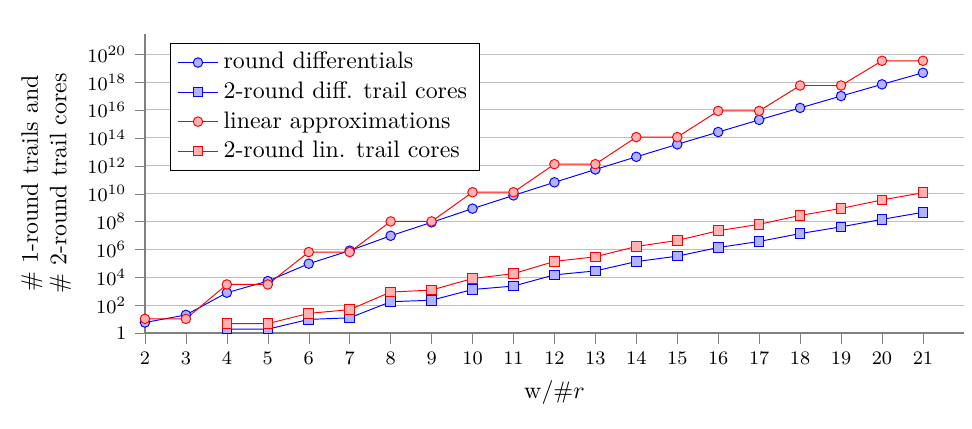
Figure 1: Number of 1-round trails and 2-round trail cores with weight per round (w / # r ), divided by